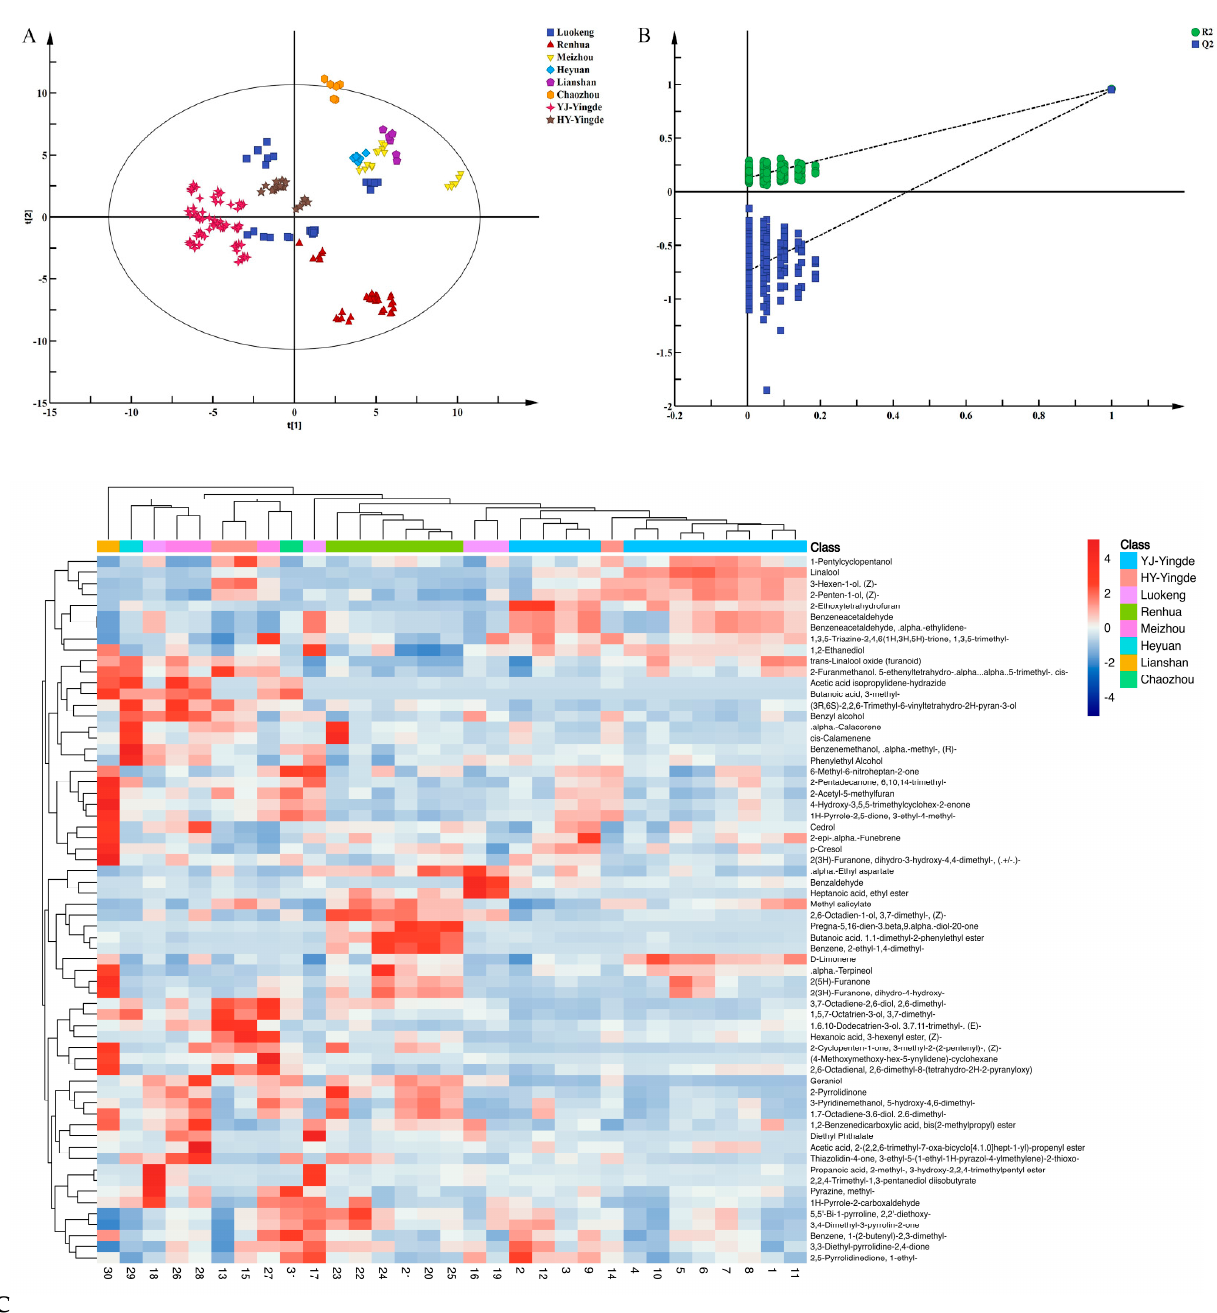
Figure 3. Profiles of VFCs in black teas from seven different areas in Guangdong Province. ( A ) PLS − DA score plot for VFCs in the black tea samples ( R 2 X = 0.787, R 2 Y = 0.944, Q 2 = 0.926). ( B ) Cross- validation plot with 200 calculations by permutation tests ( R 2 = 0.0, 0.129, Q 2 = 0.0, − 0.744). ( C ) Heat map and hierarchical clustering of the 64 di ff erential substances (VIP > 1 in PLS-DA). The red areas (intensity range of 0 − 4) present higher relative abundances of the compounds, while the blue areas show lower relative abundances (intensity range of 0 to − 4).